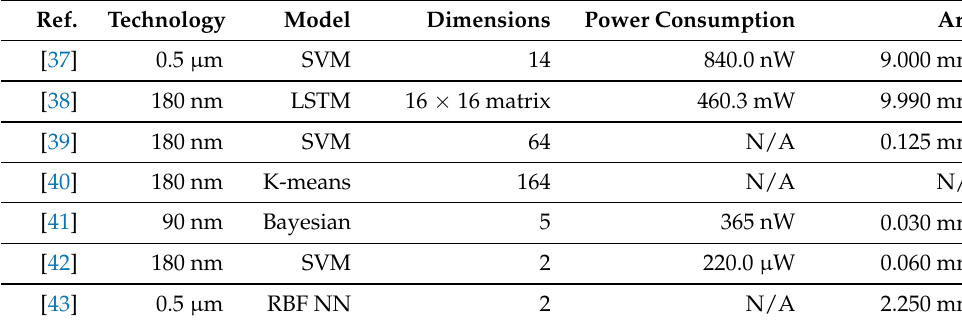
Table 2. Performance summary for analog